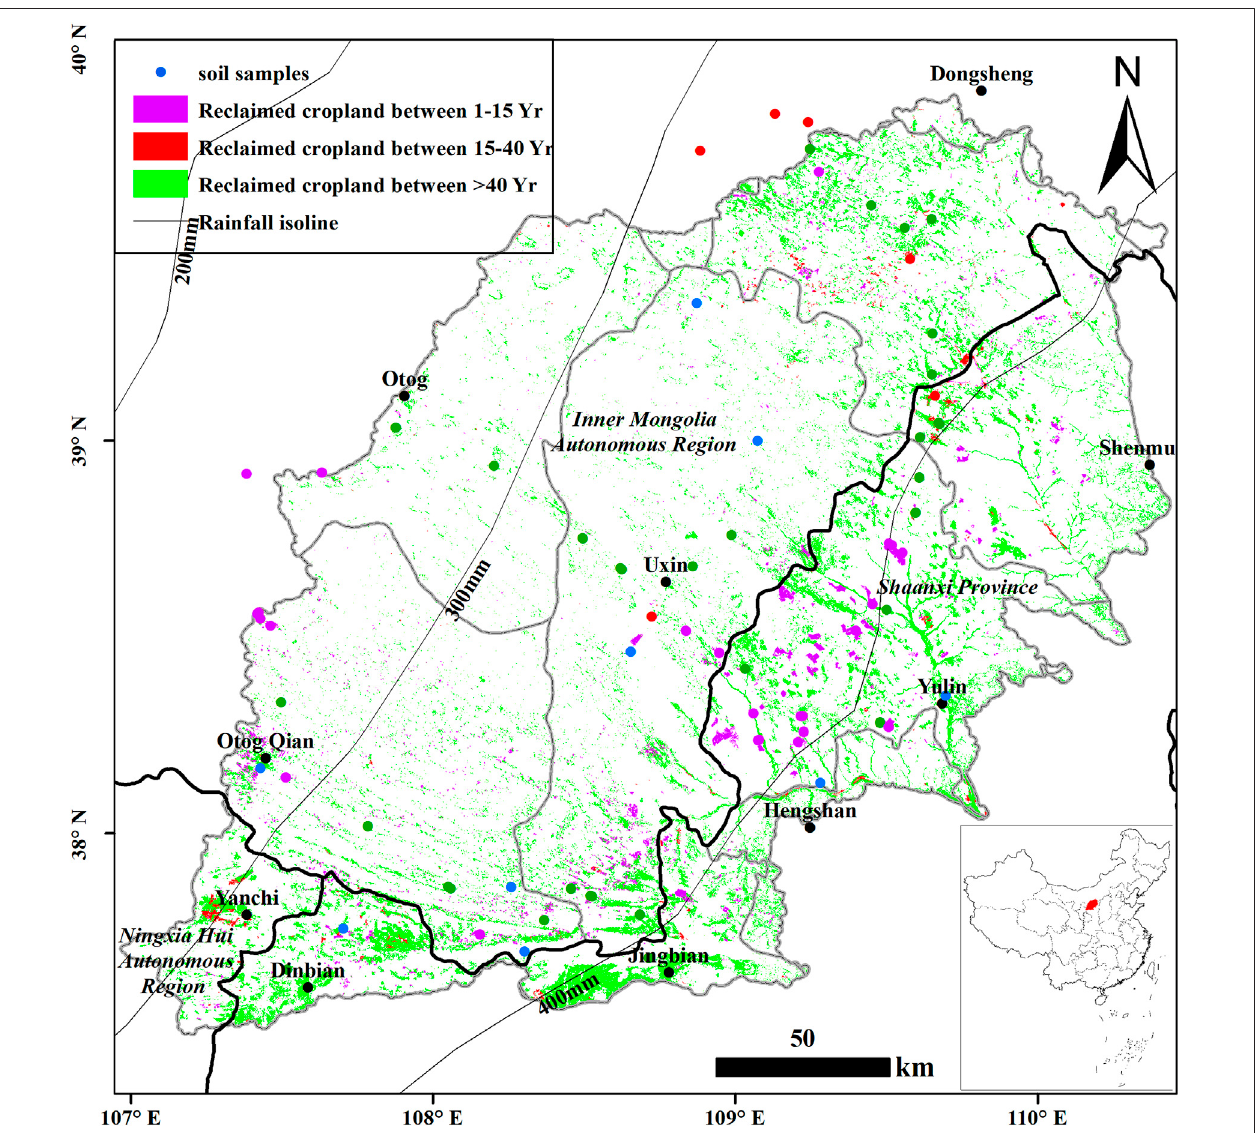
FIGURE 1 | Location of the MUSL, distribution of the soil samples and areas with the various agricultural reclamation ages. The green, red, and purple dots represent soil samples that have been farmed for more than 40 years, 15 – 40 years, and 1 – 15 years, respectively.